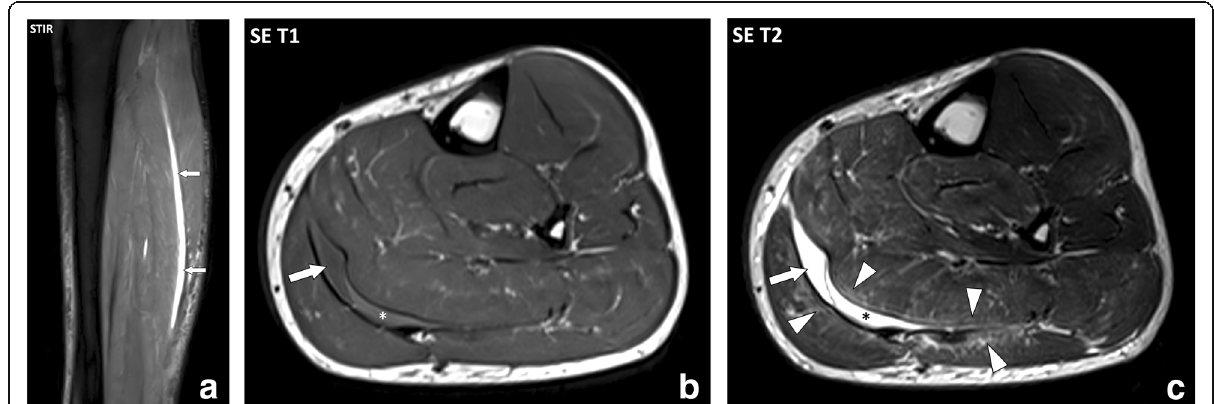
Fig. 4 a Sagittal STIR, ( b ) axial SE T1w, and ( c ) axial SE T2w images of the left leg of a 41-year-old male with myofascial injury of the calf after a skiing accident. MRI demonstrates a fluid collection at the interface between the medial head of the gastrocnemius muscle and the soleus muscle (arrows) with a component of intermediate signal intensity on the T1w image corresponding to blood (asterisks). Note the infiltration of the connective tissue of the muscles adjacent to the collection